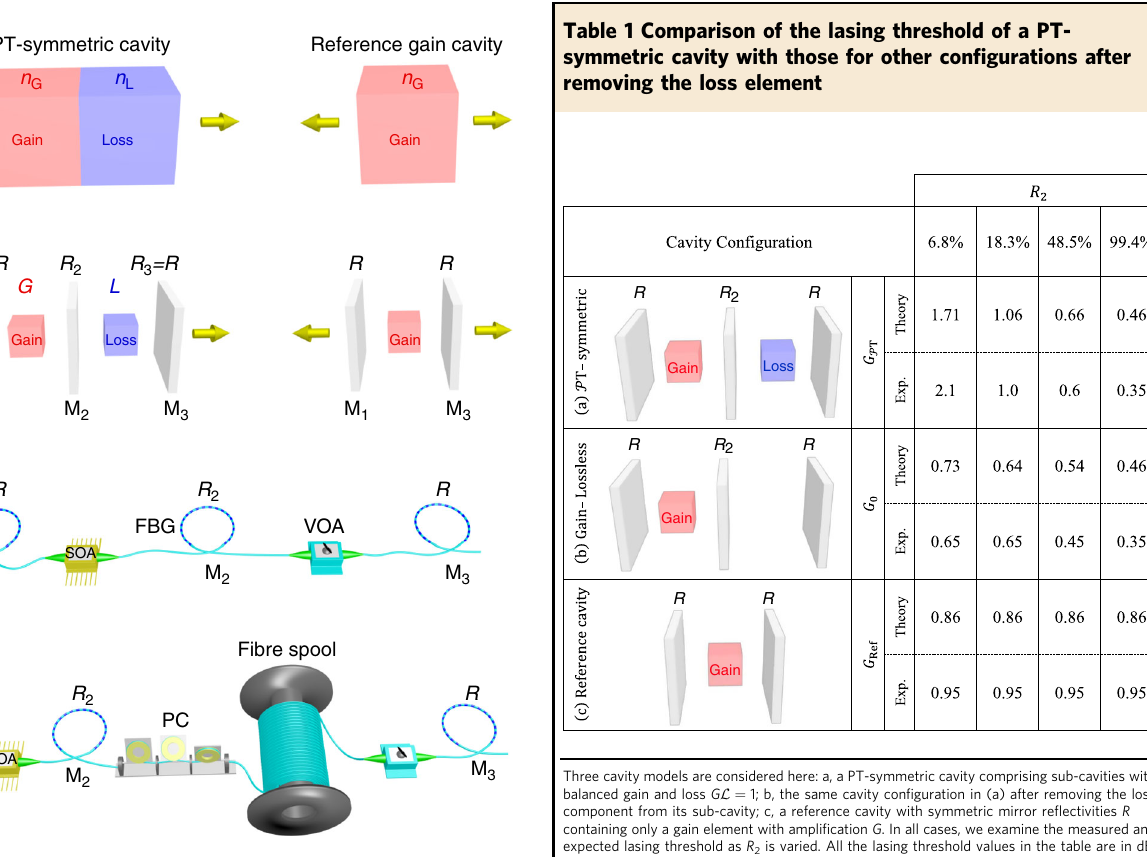
re fl ectivities R 1 , R 2 and R 3 , respectively. The distributed gain and loss are (attenuation factor L ), respectively. PT-symmetry requires that R 1 = R 3 = R